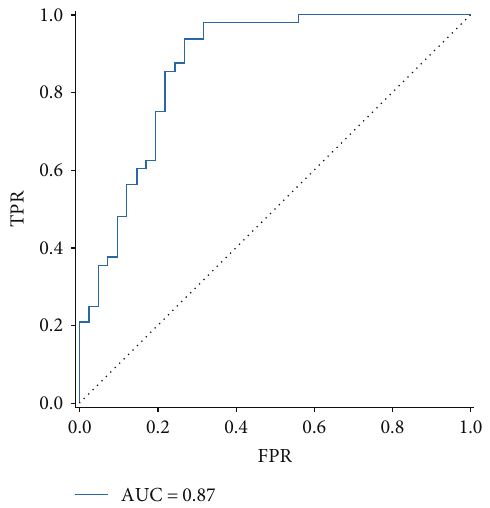
Figure 3: The receiver operating characteristic (ROC) curve of metrics. The image of ROC was displayed using the Matplotlib toolkit in Python. FPR, false positivity rate; TPR, true positivity rate; AUC, area under the ROC